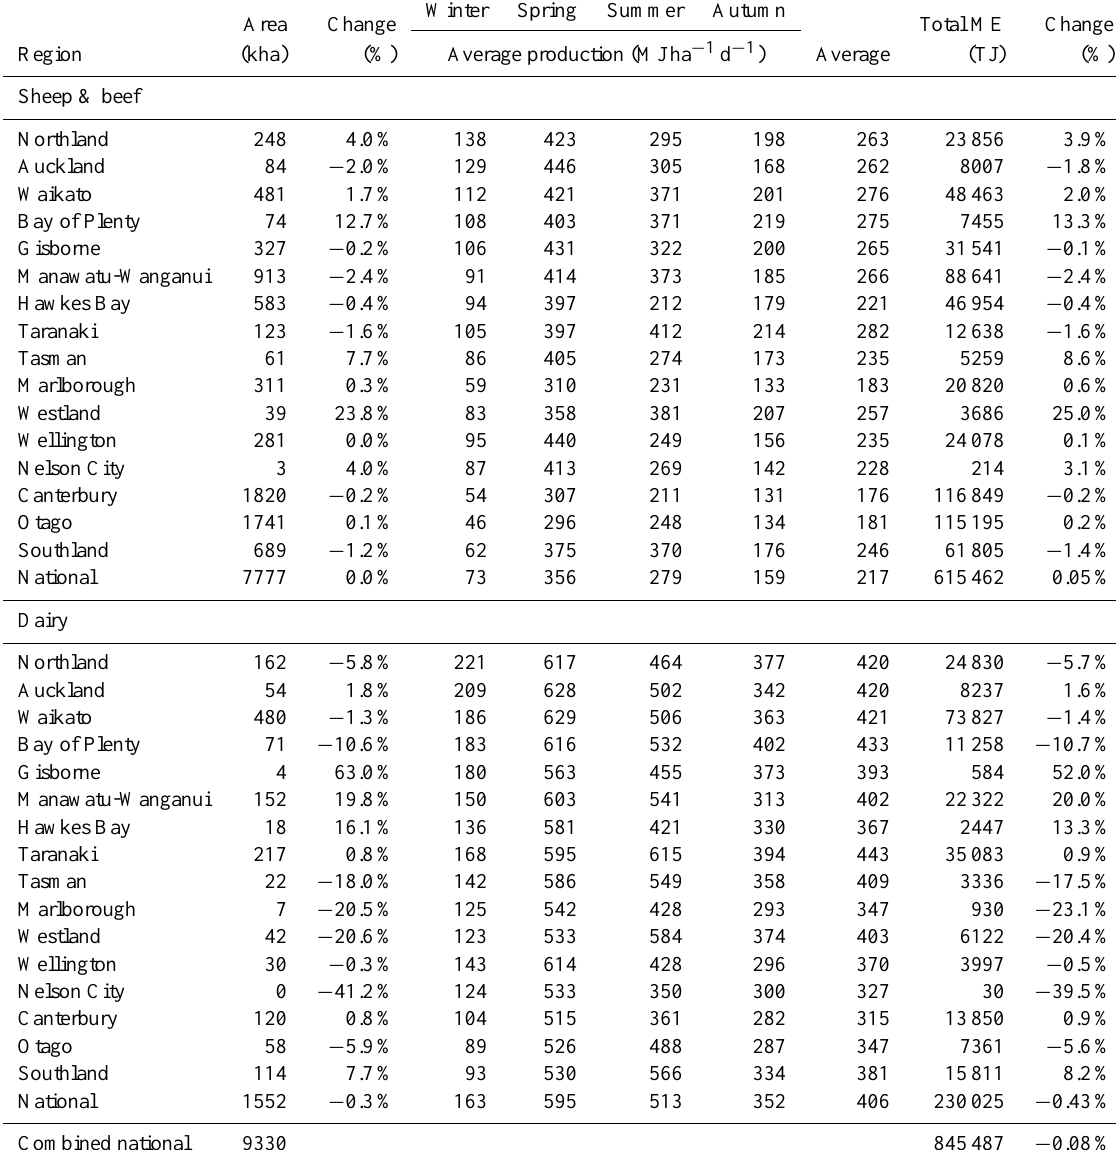
Total ME Change